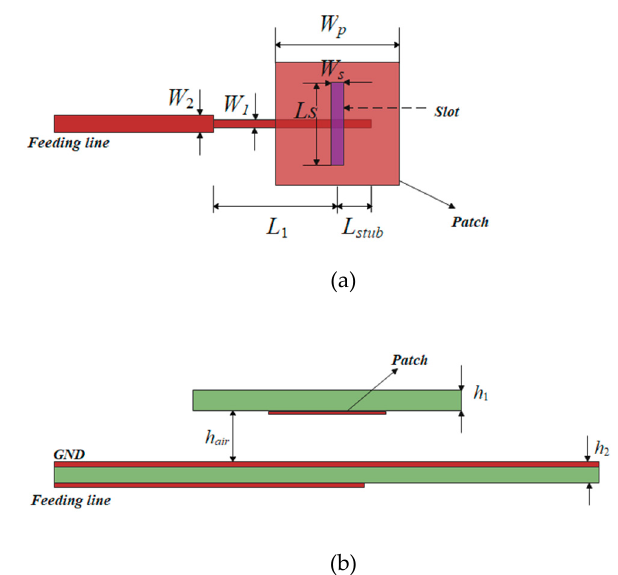
Figure 2. Structure of the microstrip slot antenna. ( a ). Top view. ( b ). Front view. This patch is coupled to the feeder through a ground plane gap, and the patch and ground plane are separated by an air gap to suppress surface waves, which can be fed into the cavity and degrade the antenna performance of the F-P resonator [14]. The antenna is